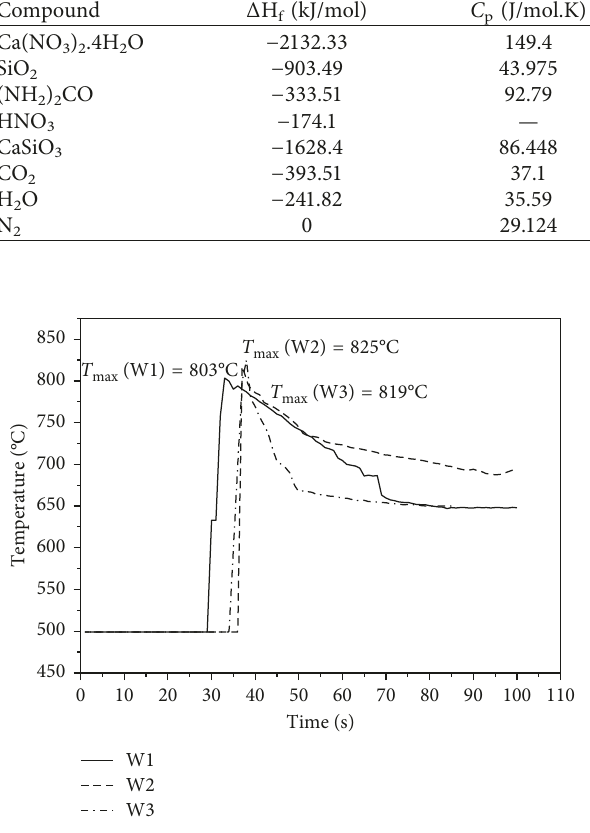
Figure 1: Time-temperature profile of aqueous solution com- bustion synthesis of wollastonite (initial furnace temperature of 600 ° C).